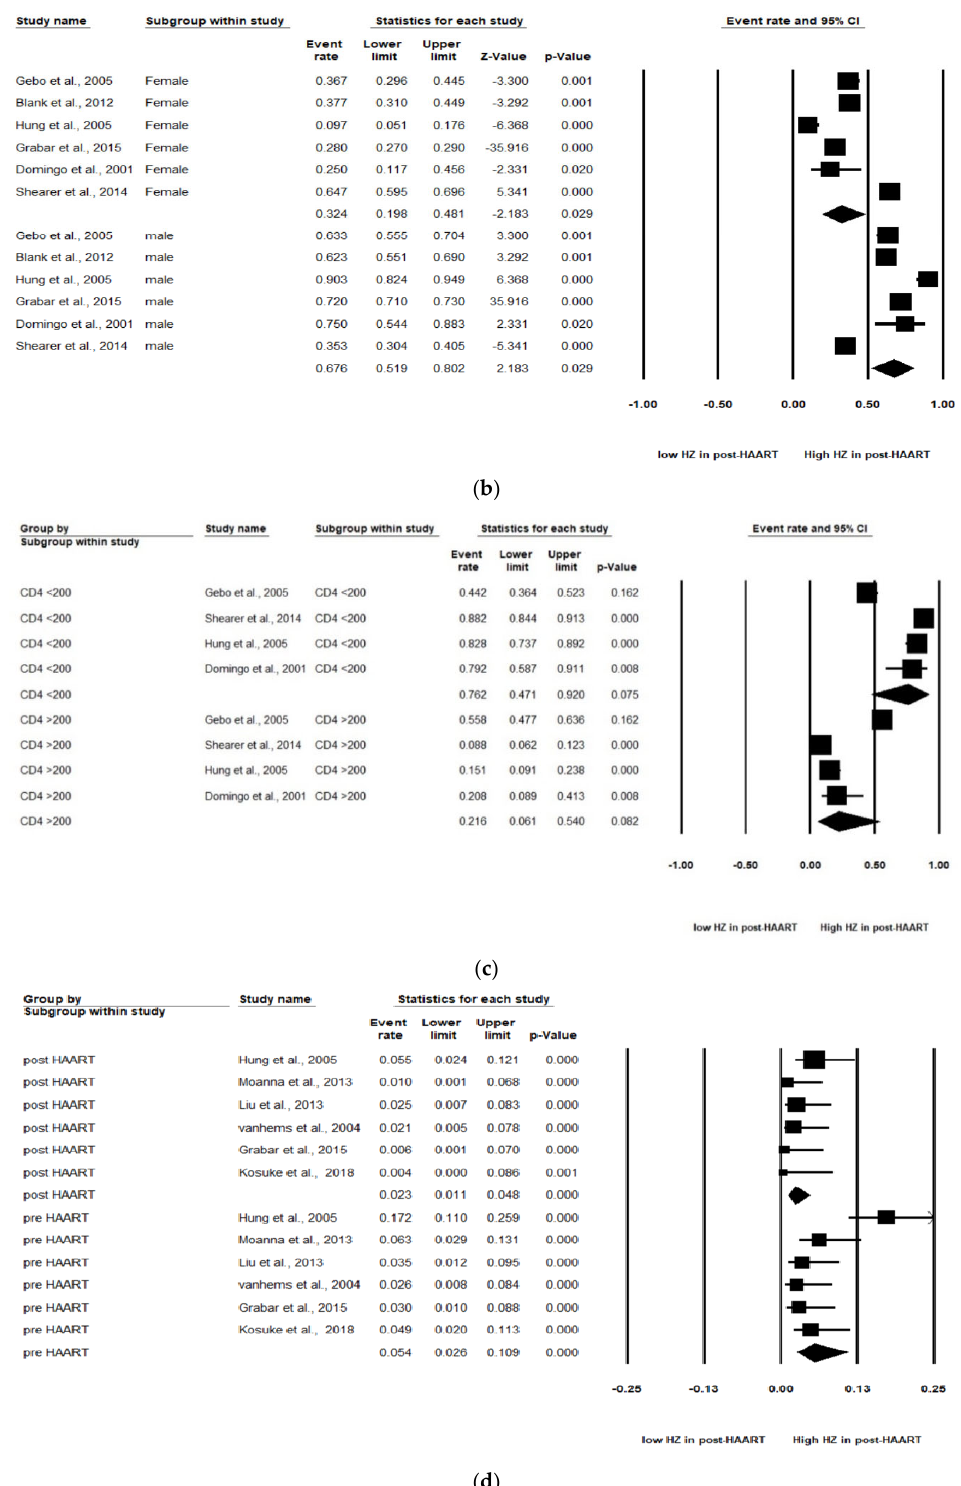
Figure 2. Meta-analyses of ( a ) HZ incidence of HIV-infected patients among ART-era therapy, ( b ) subgroup segmented by sex, ( c ) subgroup segmented by CD4 count level and ( d ) subgroup segmented by ART use. (Note: in the graph, the square represents the effect size of each study. The bigger the square, the more participants in the study. A horizontal line represents the 95% confidence intervals of the study result, with each end of the line representing the boundaries of the confidence interval. The diamond represents the combined effect. Pre-ART = not receiving ART. Post-ART = receiving